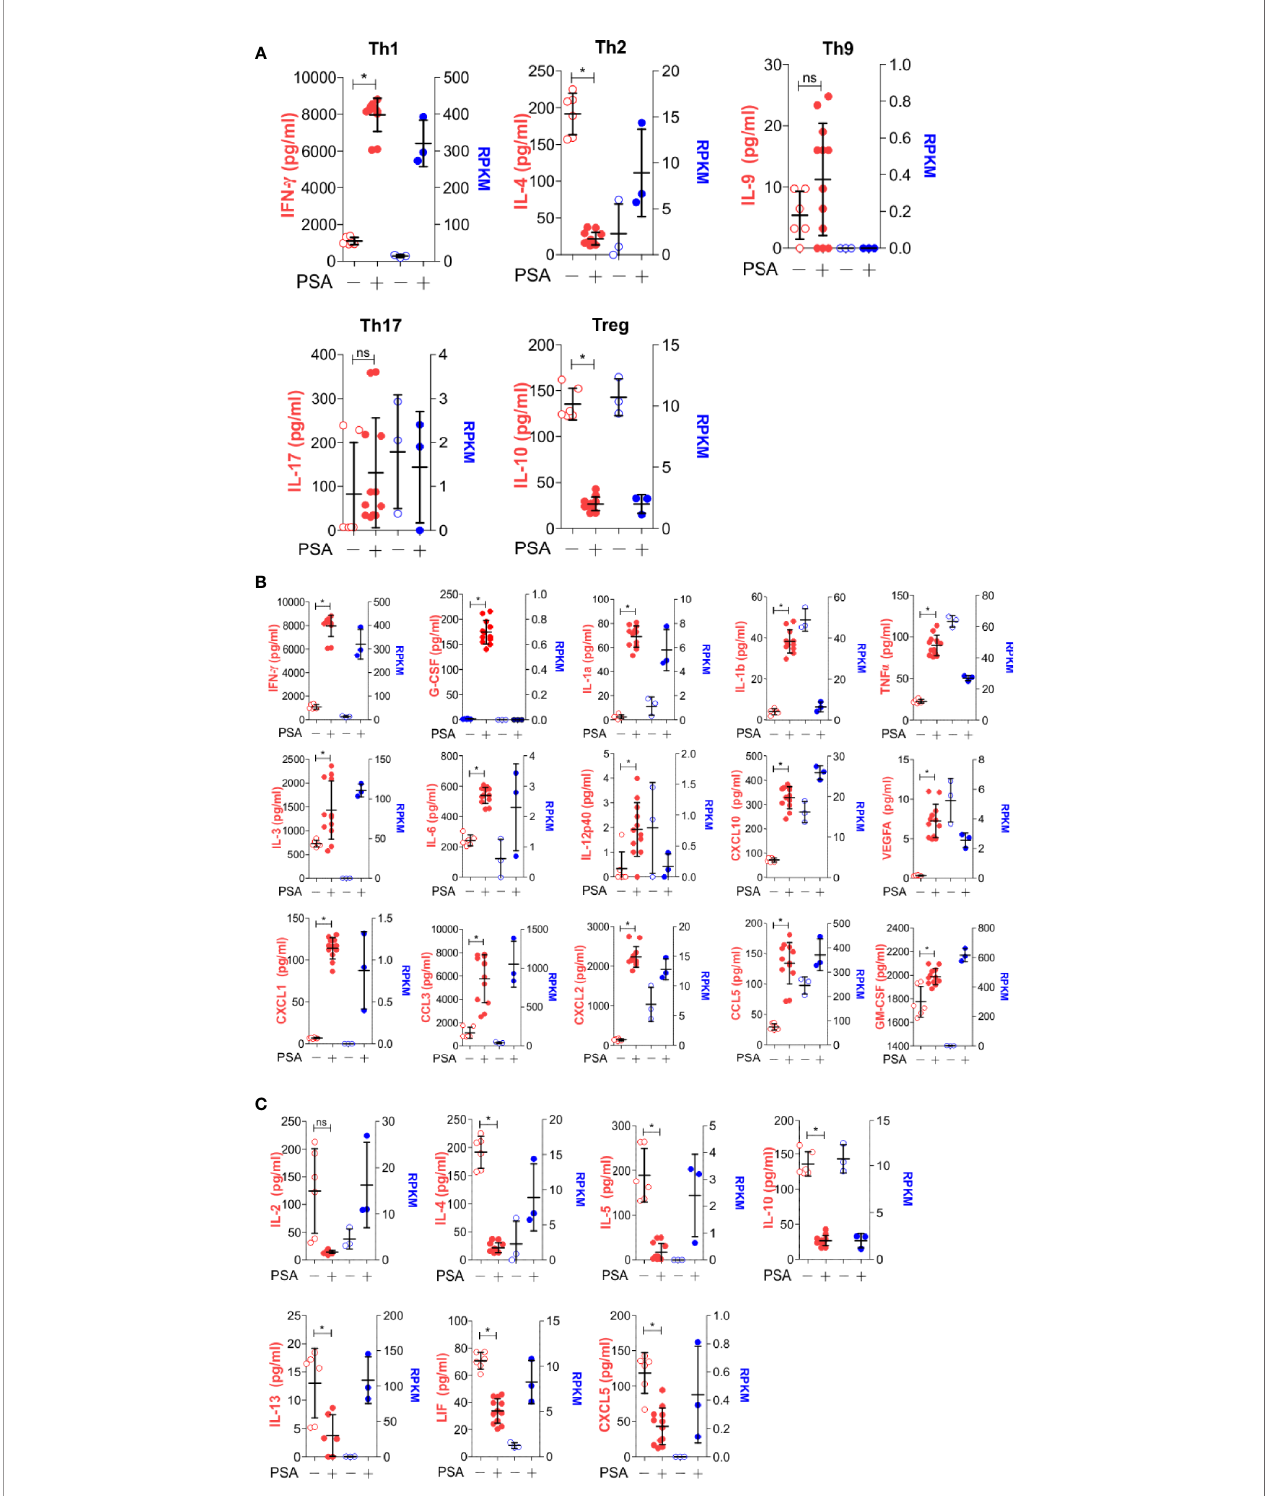
FIGURE 4 | Secreted molecule pro fi le of PSA exposed cells. Luminex analysis (Mouse Cytokine/Chemokine Array 32-plex) was used to determine secreted molecule pro fi le of PSA exposed APC and T cell co-cultures after 7 days. Data shown re fl ects secreted proteins (left, red) and matching RNA-seq data (right, blue). (A) T subtyped associated cytokines. (B) Molecules that signi fi cantly increased (P ≤ 0.05) with PSA exposure. (C) Molecules that signi fi cantly decreased (P ≤ 0.05) with PSA